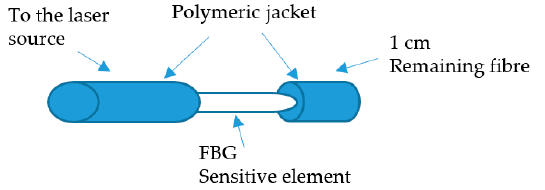
Figure 1. Representation of the FBG